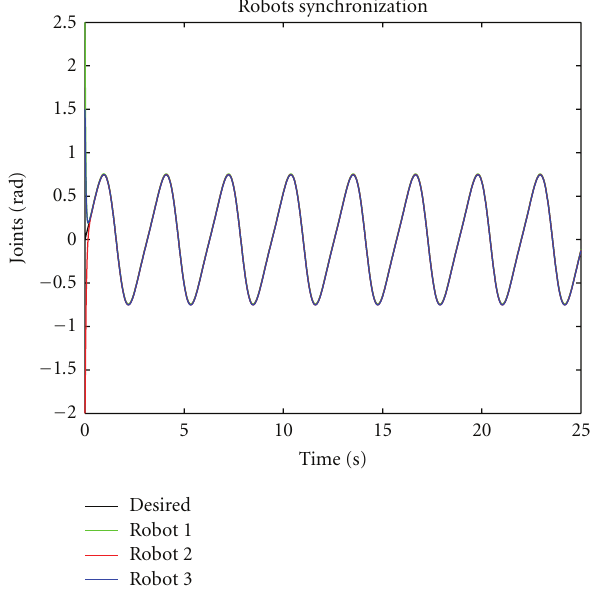
Figure 2: Synchronization of robots without uncertain parameters.